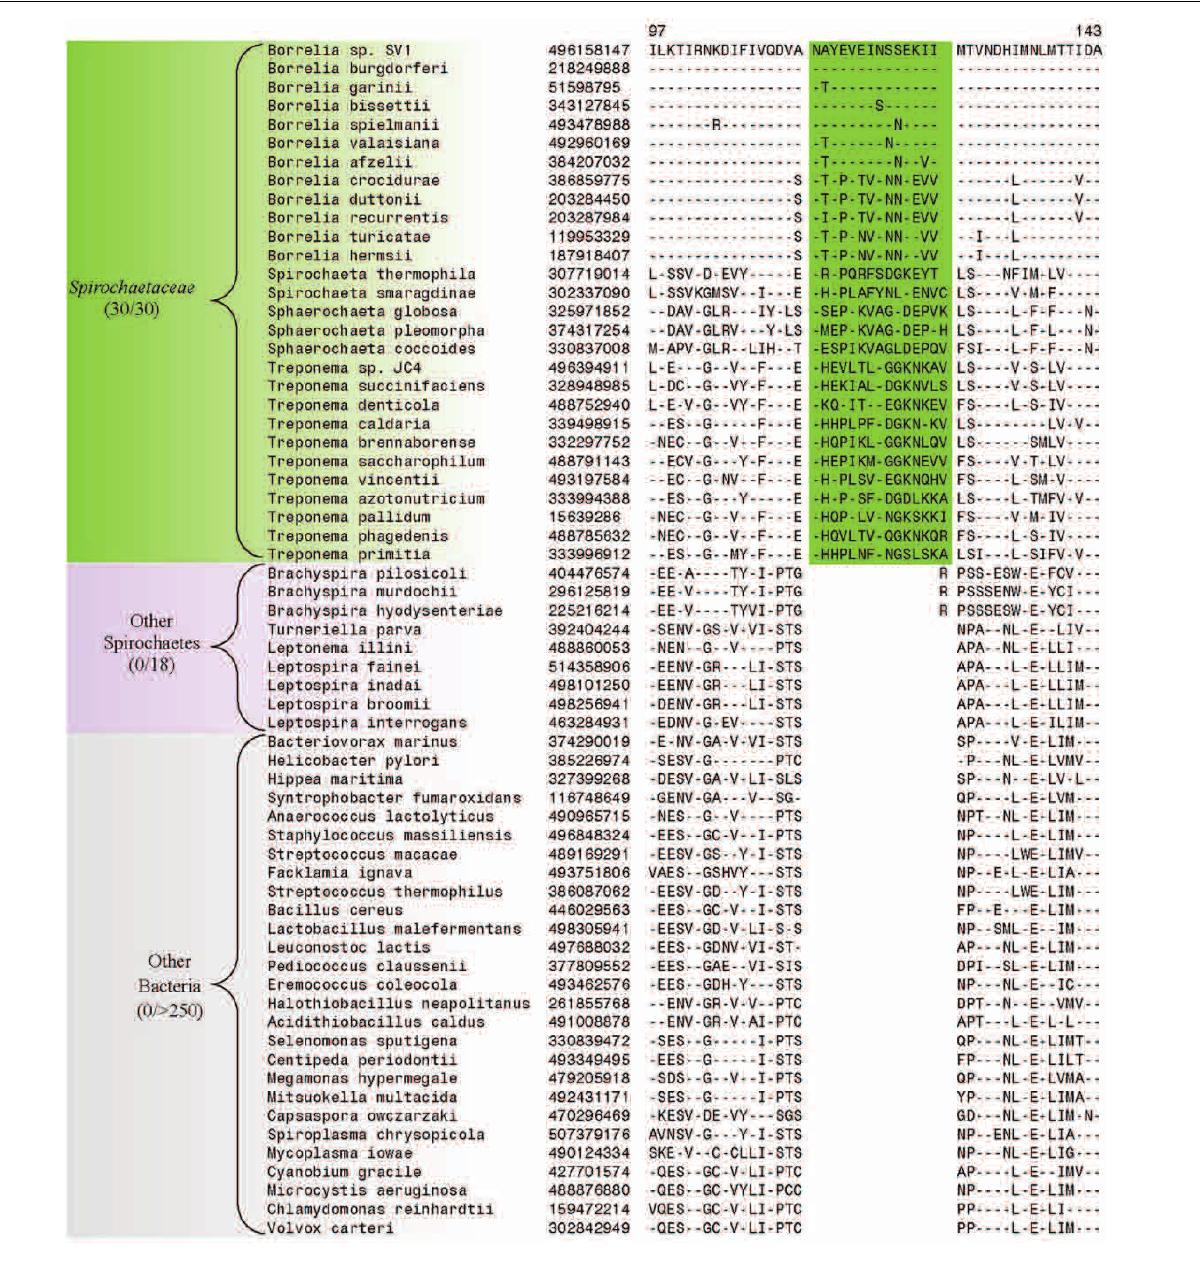
sequence homologs of any other sequenced bacteria. Sequence information for other Spirochaetaceae specific CSIs is presented